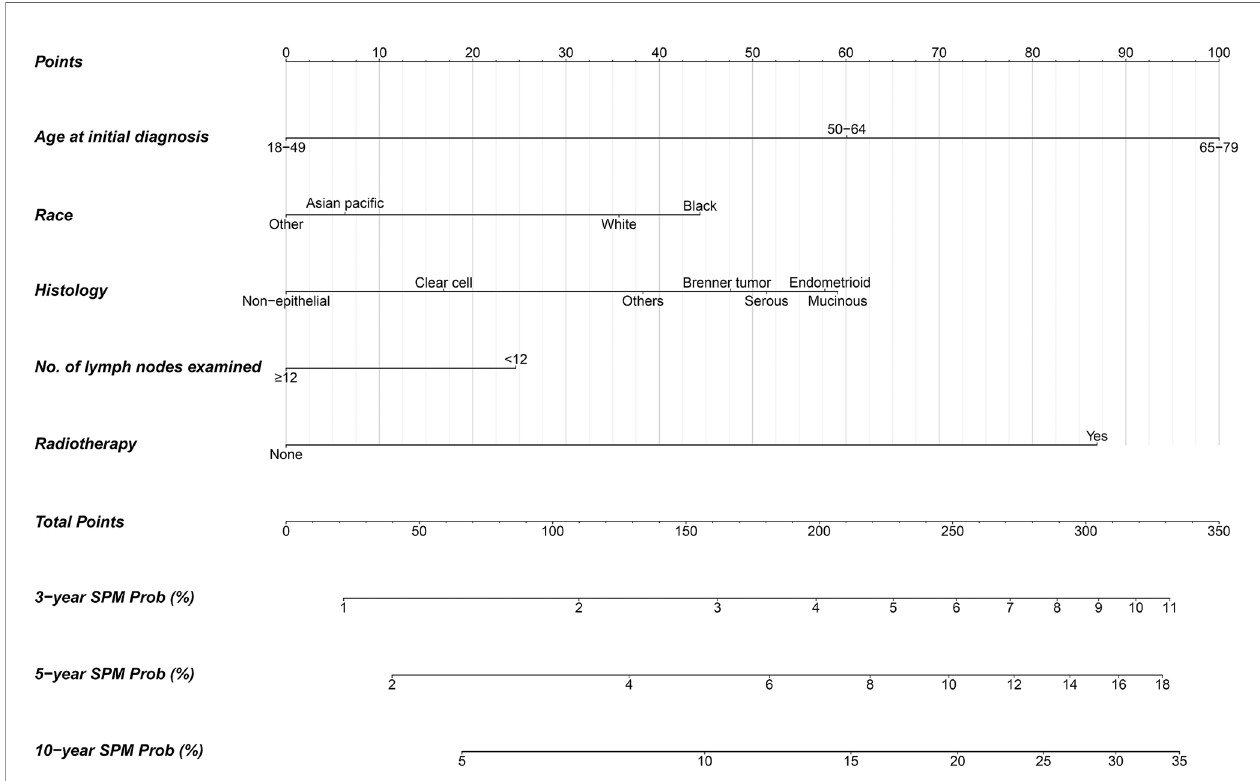
FIGURE 3 | Competing-risk nomogram for predicting 3-, 5-, and 10-year probabilities of developing second primary malignancies in early-stage OC patients.